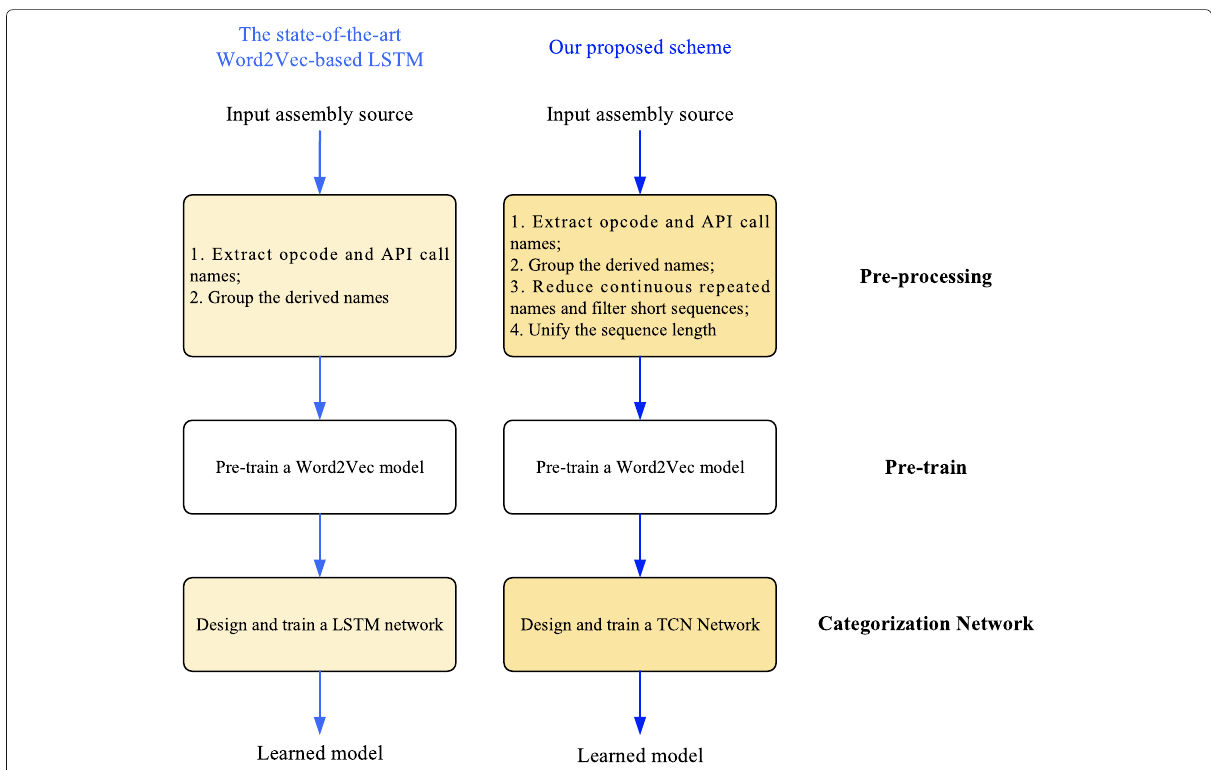
Fig. 4 Comparison between the state-of-the-art Word2Vec-based LSTM and our proposed scheme. The main different parts are shaded light